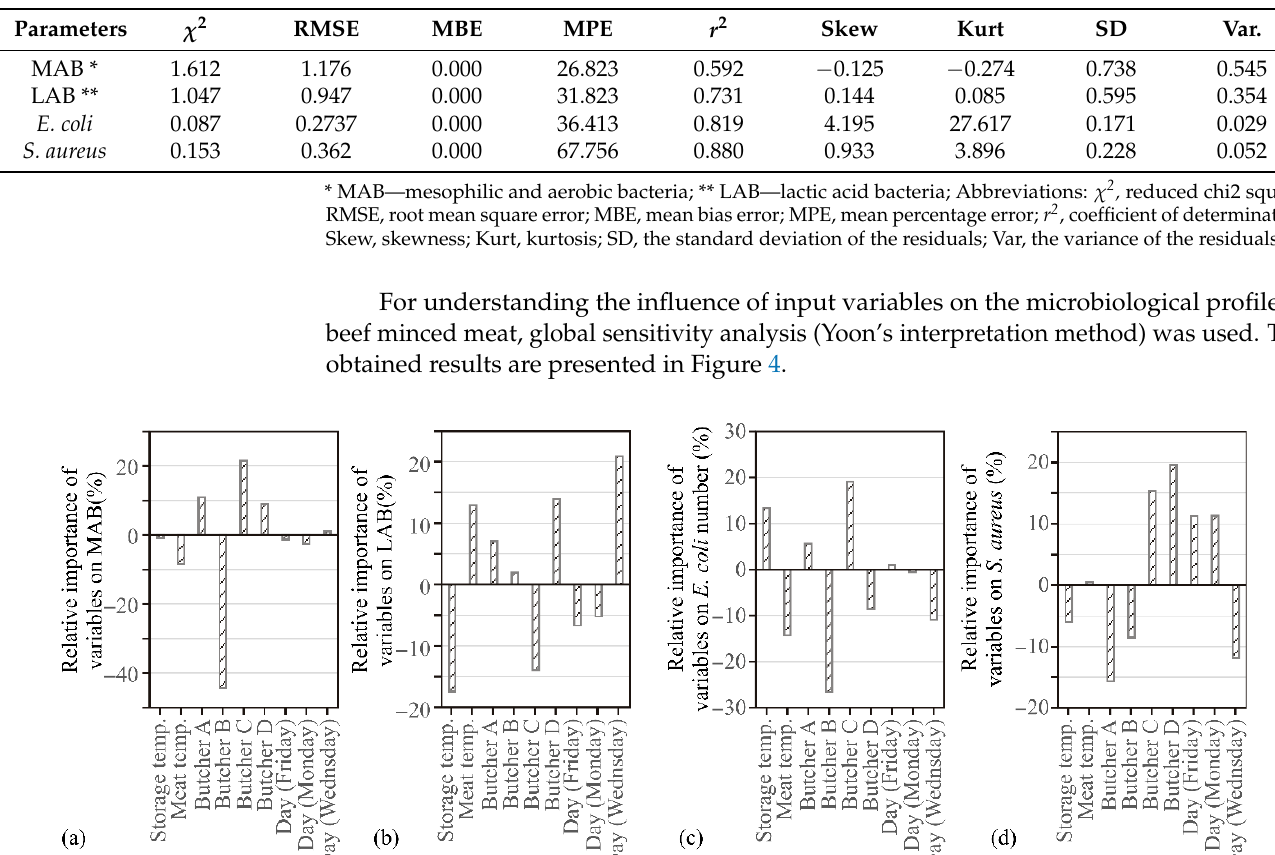
Table 5. The ‘goodness of fit’ tests for the microbiological profile prediction of beef minced meat.